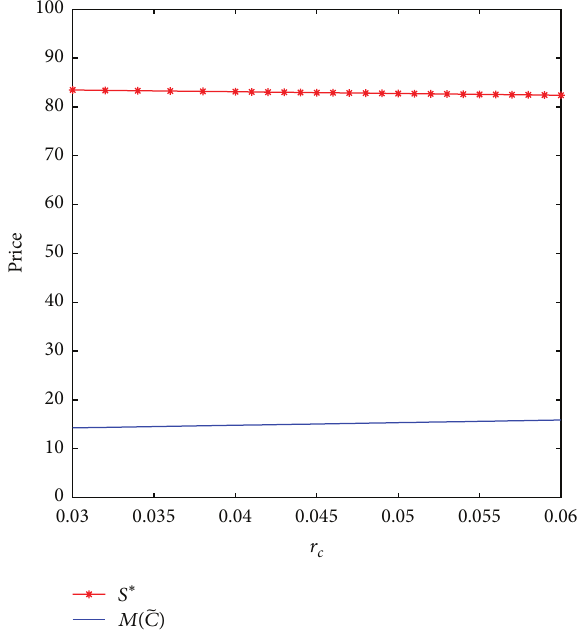
𝑀(̃𝐶) with respect to 𝑟 𝑐 .